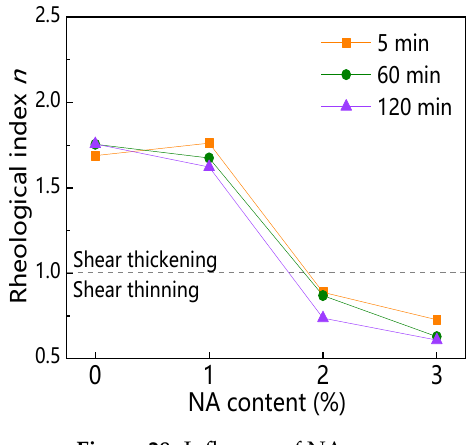
Figure 28. Influence of NA on n.